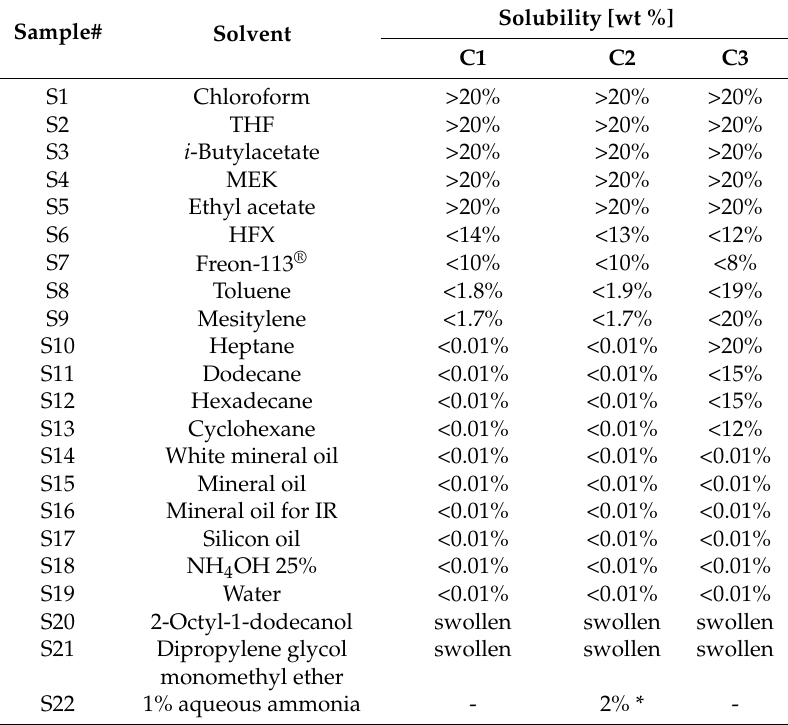
Table 4. Solubility of the terpolymers in different